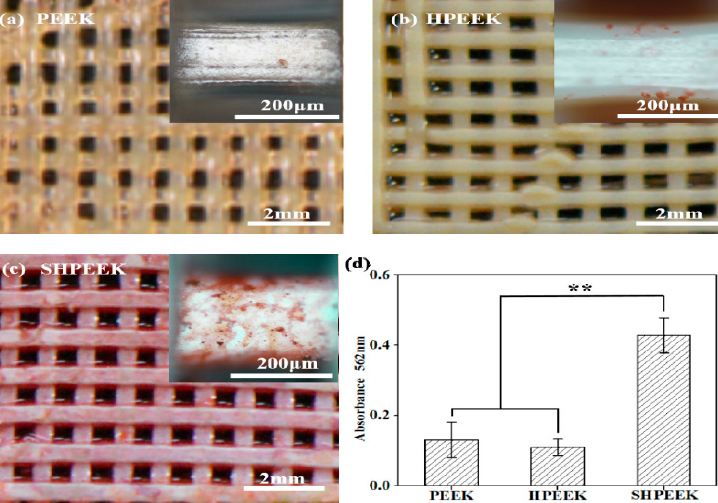
Figure 29. The proliferation of MC3T3-E1 cells on PEEK, HPEEK and SHPEEK scaffolds at different time points. * p < 0.05 and ** p < 0.01. Reproduced from [216] with permission of Elsevier under a Creative Commons license.